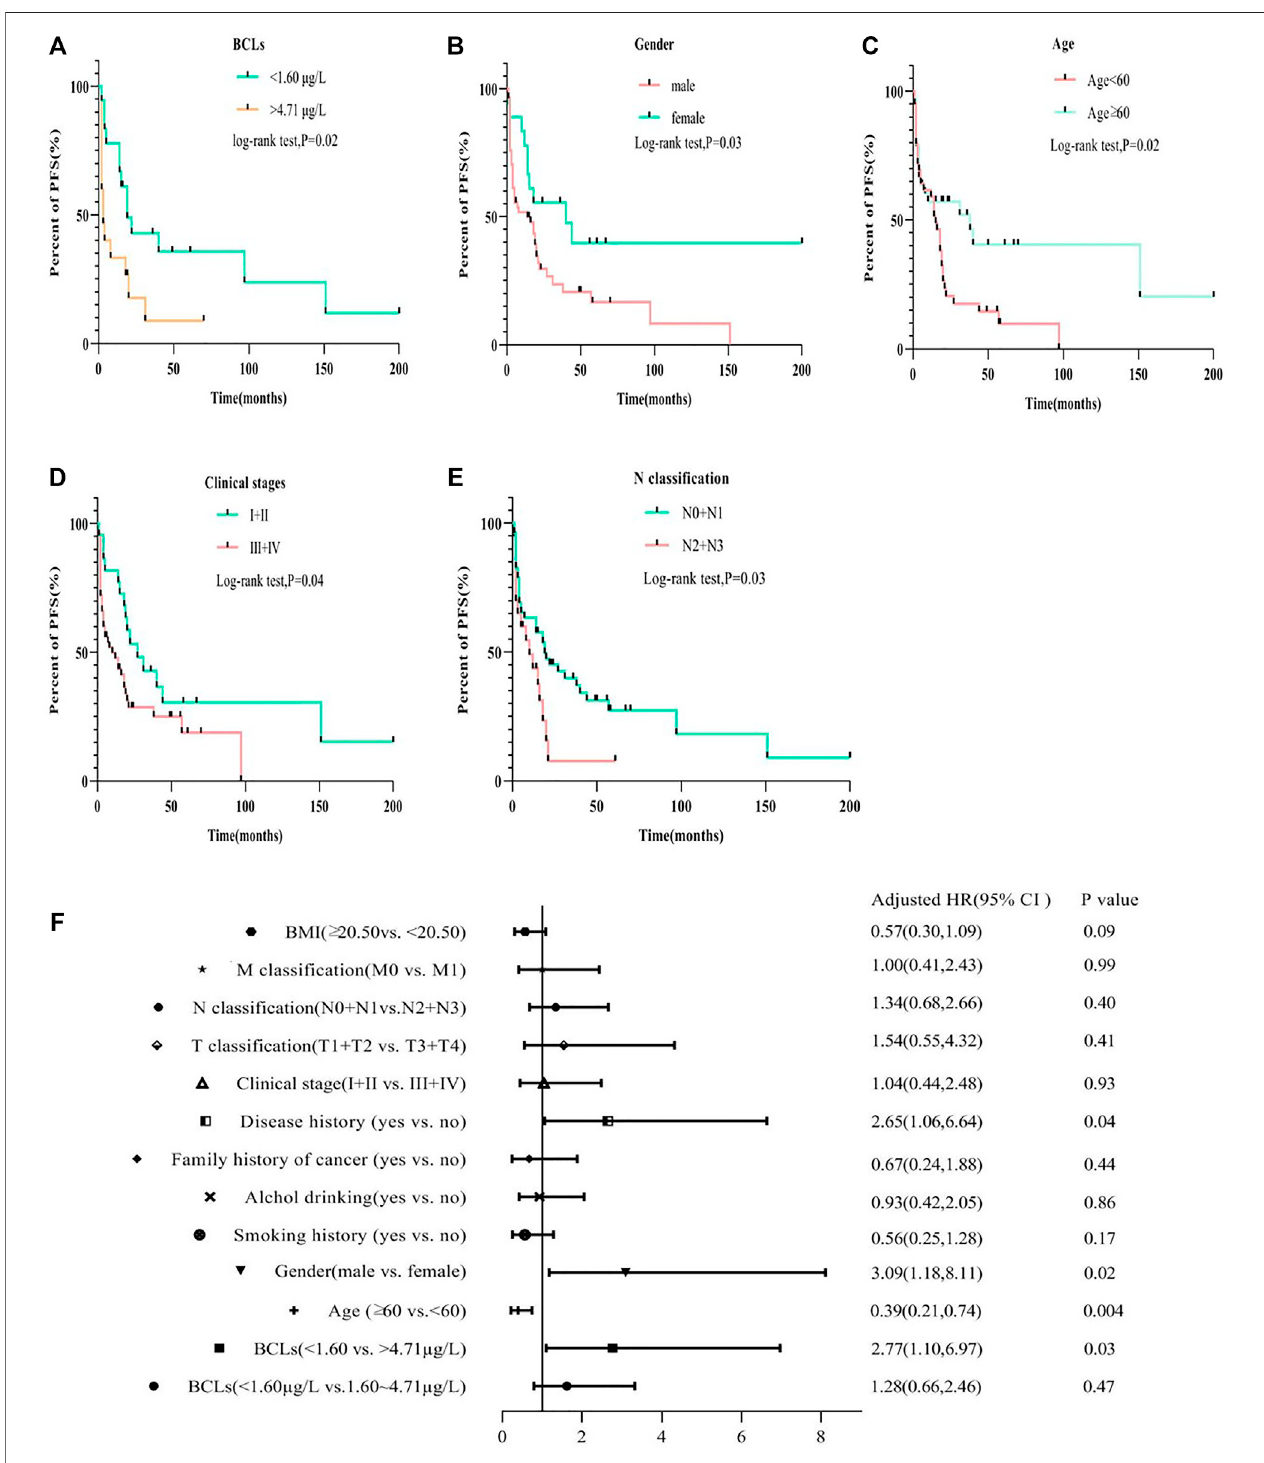
FIGURE 2 | Compare the PFS of ESCC patients with Cd burden, gender, age, clinical stage, and N classi fi cation by Kaplan – Meier log-rank tests (A – E) and multivariate Cox analysis for the PFS risk related to different groups (F) .